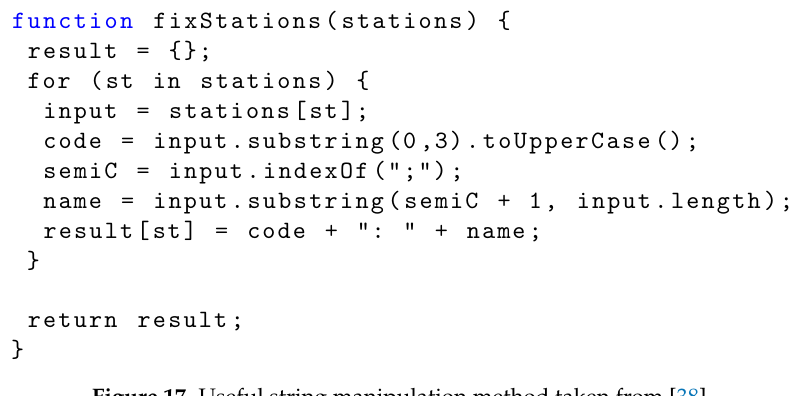
Figure 17. Useful string manipulation method taken from